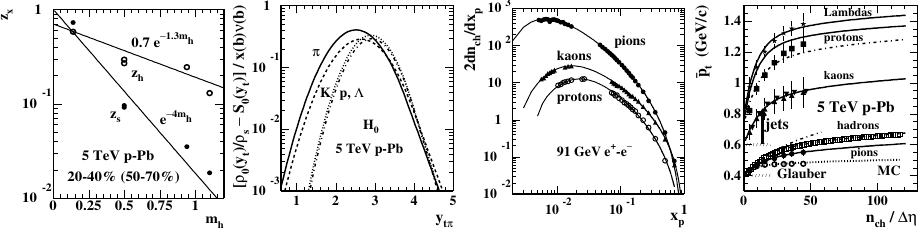
Figure 7. First: TCM soft z s and hard z h fractions for identified hadrons relative to unidentified hadrons vs hadron mass. Second: Spectrum hard components for five hadron species. Third: Fragmentation functions for three hadron species. Fourth: PID ¯ p t data (points) from 5 TeV p -Pb collisions for seven multiplicity classes vs TCM (solid